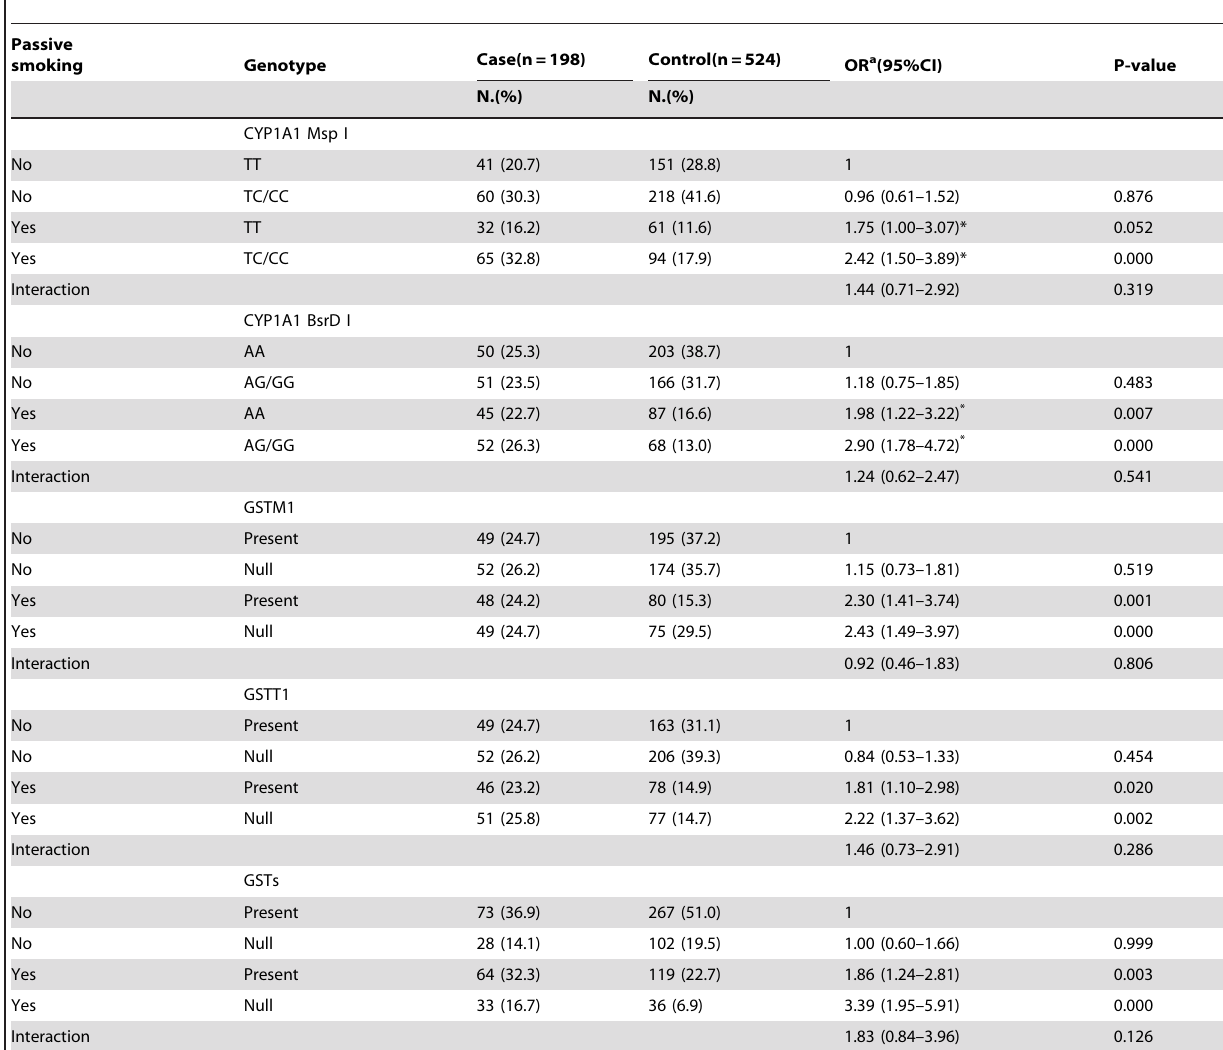
Table 3. Interaction between maternal passive smoking during pregnancy and single genotype of CYP1A1 and GSTs on risk of spontaneous